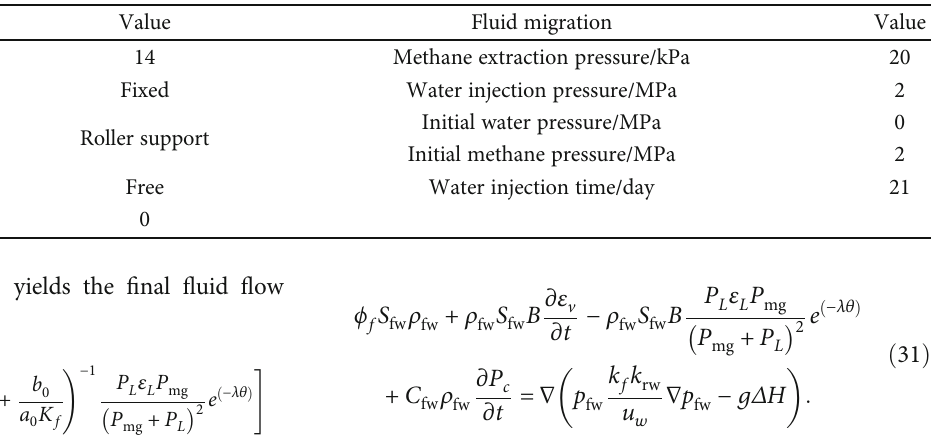
Table 2: Numerical model boundary